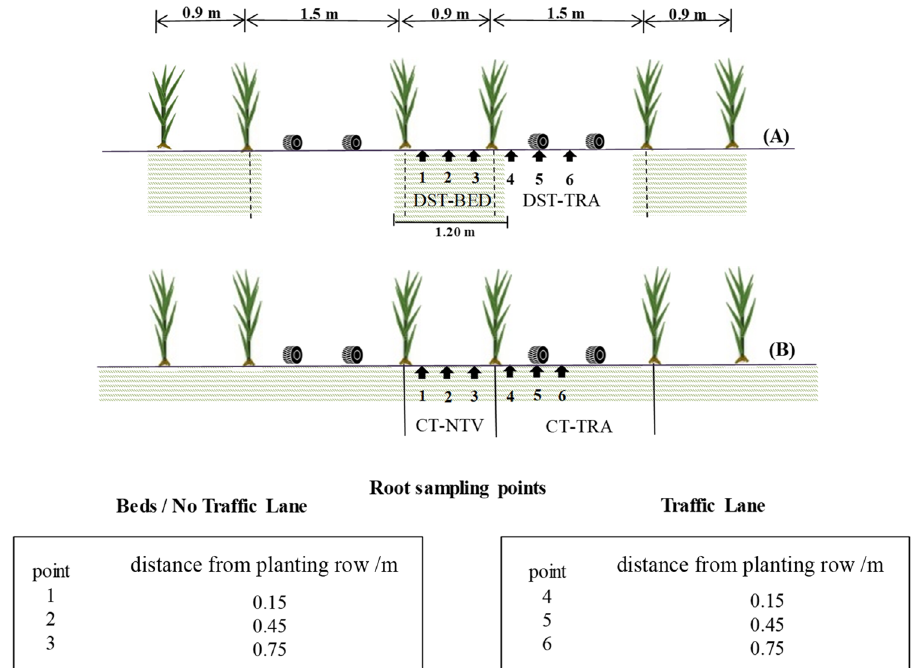
Figure 1. Double row spacing of 0.90 × 1.50 m for sugarcane. ( A ) Deep Strip Tillage (DST) with a tilled and no traffic lane (DST-BED), and a traffic lane (DST-TRA). ( B ) Conventional Tillage (CT) with a no traffic lane (CT-NTV) and a traffic lane (CT-TRA). Hachured areas indicate soil tilled (1,20 m for DTS-BED corresponding to deep strip tillage equipment width). Root sampling points are relative to the planting row. The collected roots comply with relevant institutional, national, and international guidelines and